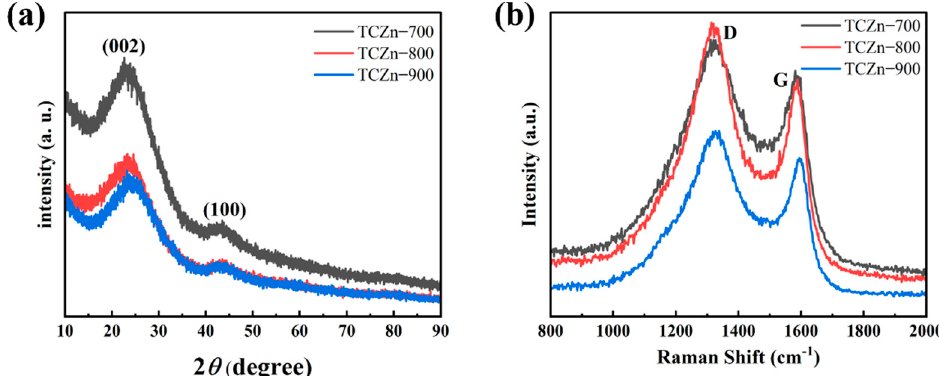
Figure 4. ( a ) XRD patterns and ( b ) Raman spectra of TCZn-700, TCZn-800 and TCZn-900.